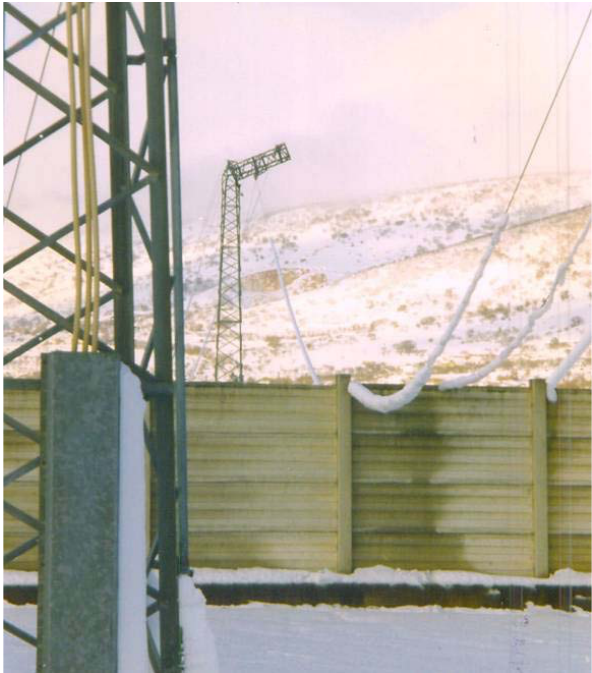
Fig. 2. Tower collapse due to overload ice on conductors during a wet snow event (Puglia – Italy; winter